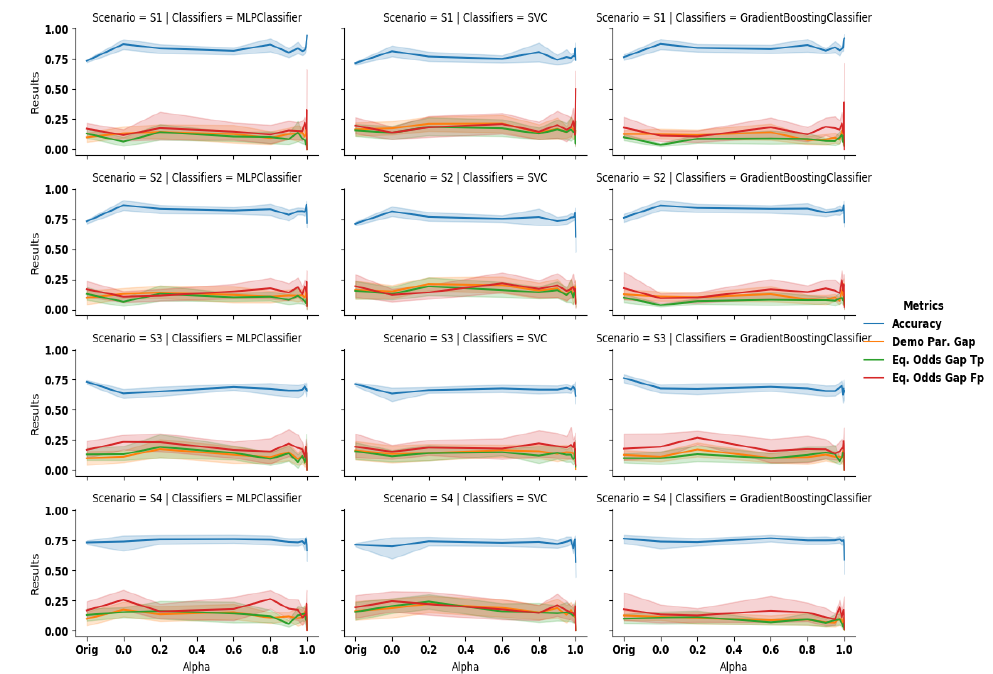
Figure A3. Accuracy (blue), demographic parity gap (orange) and equalized odds gap (true positive rate in green and false positive rate in red) computed for scenarios 1, 2, 3 and 4 (top to bottom), with the classifiers GB, MLP and SVM (left to right) on german credit